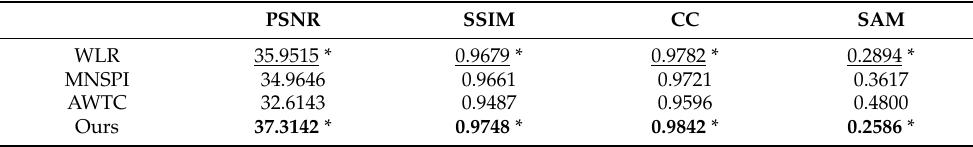
Table 2. Quantitative evaluation of simulation